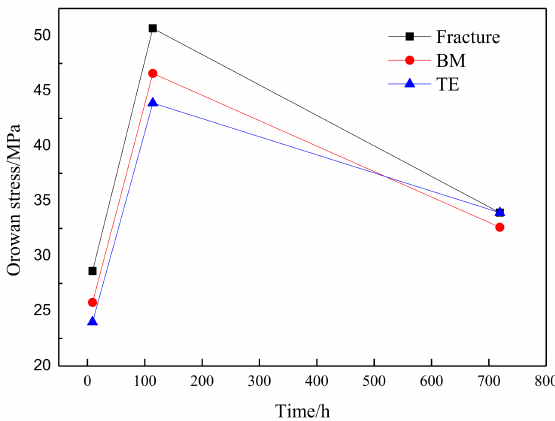
Figure 12. Orowan stress of Laves phase changes with creep